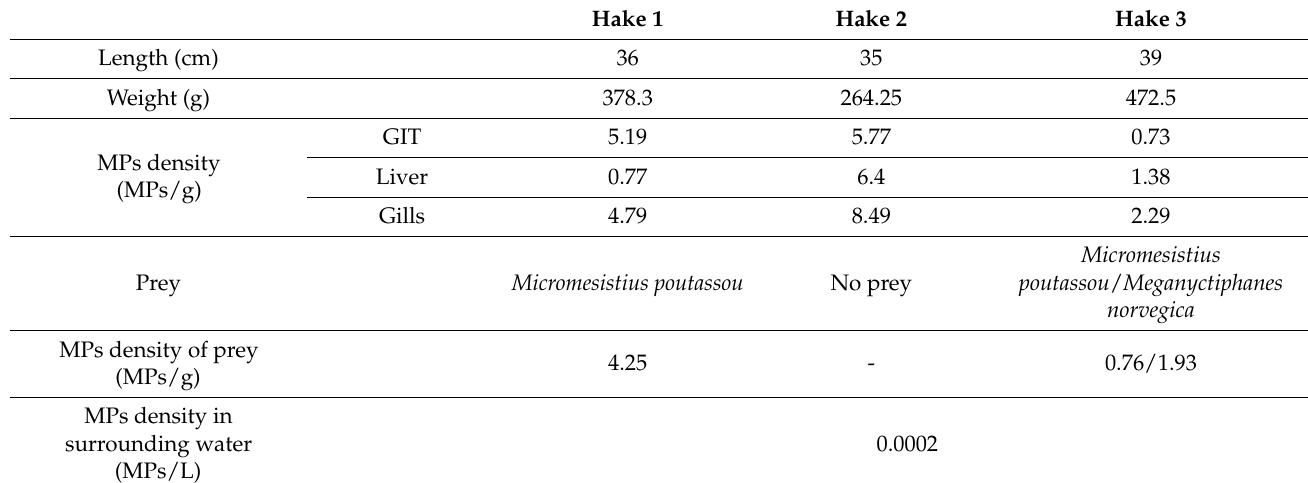
Table 1. Length and weight of hakes. Prey species in corresponding to each predator ( M. norvegica was found inside M. poutassou ). MPs concentration in MPs/g for hakes, preys and MPs/L for surrounding water from the same fishing area.